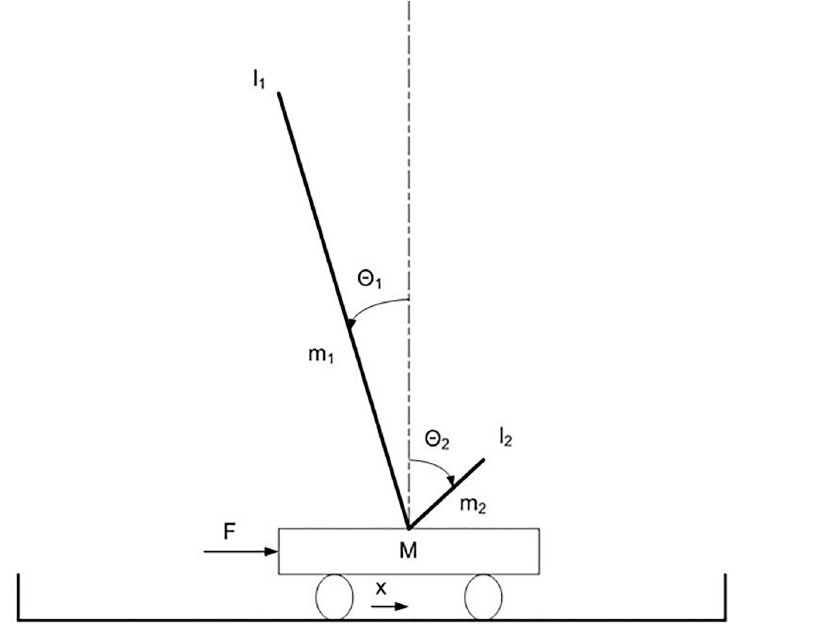
Fig 3. The double-pole balancing